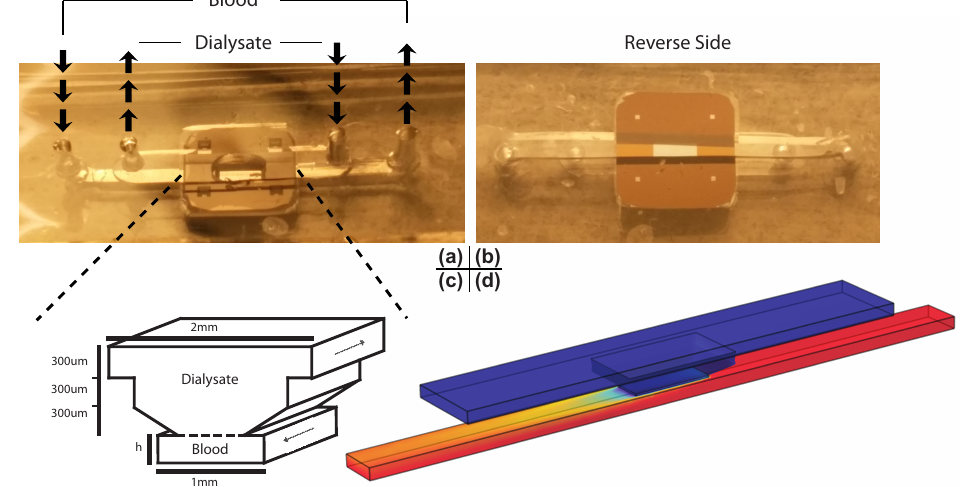
Figure 2. Photos, schematic, and COMSOL finite element model of the experimental system. ( a ) Photo of the experimental system taken from the access side. The dialysate channel passes over the membrane (in the center of the chip) while the blood channel passes underneath it; ( b ) Photo of the same system taken from the other side. The four squares in the corners of the chip in the photographs are additional regions of membrane, but are not in use during this particular experiment; ( c ) Schematic of active section of experimental system. The membrane spans 70% of the blood channel’s width, and the dialysate and blood are in counterflow. The dashed line represents the membrane; ( d ) Snapshot of the finite element model. It is colored with an example heat map representing concentration of a solute as it moves through the system, where the highest concentration is bright red while the lowest is dark